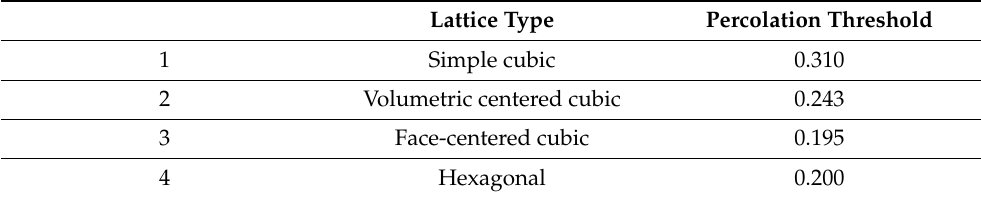
Table 1. Percolation thresholds for some types of three-dimensional